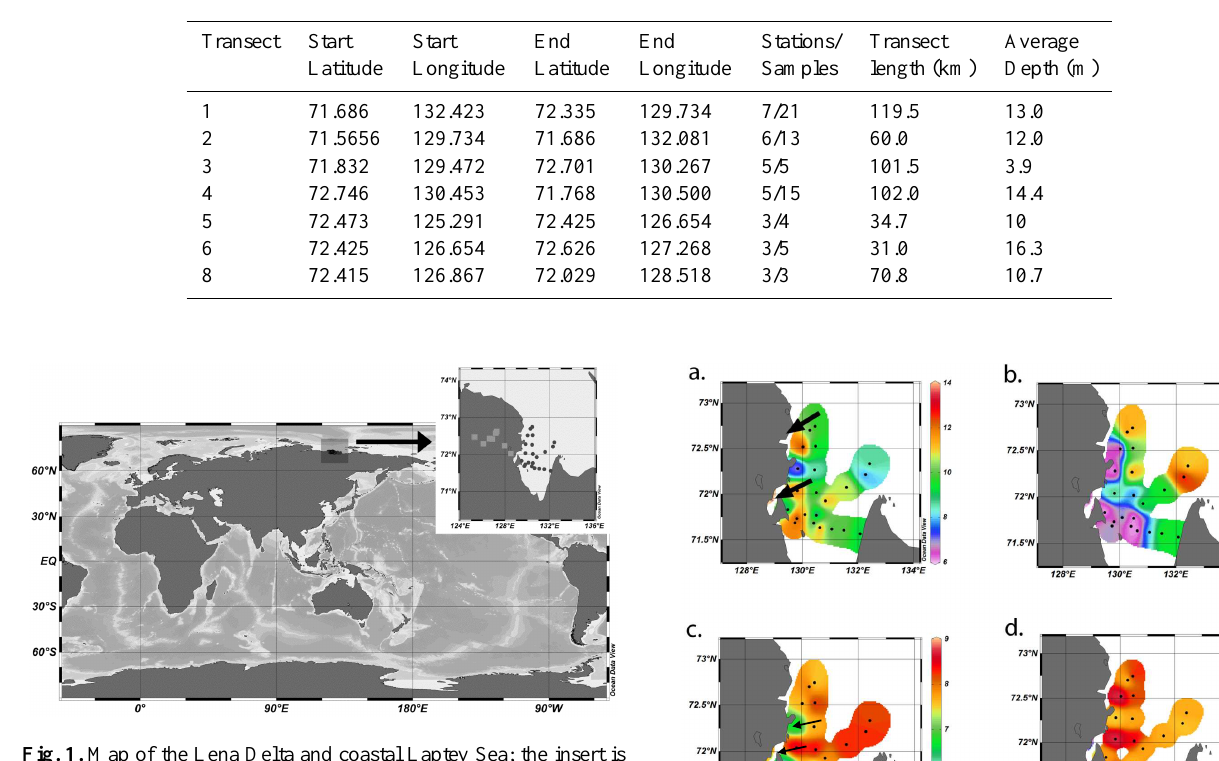
Table 1. Geographical co-ordinates of the sampled transects. Average depth was estimated based on the depth of the individual transect stations.